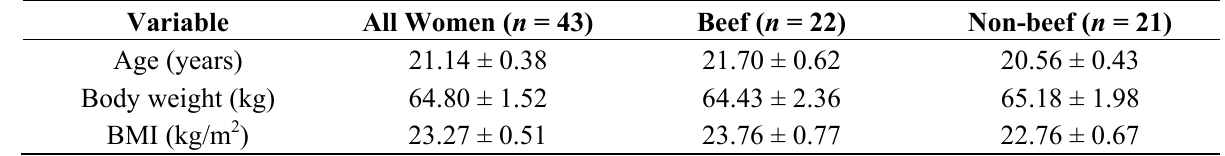
Table 2. Baseline characteristics of intervention participants.